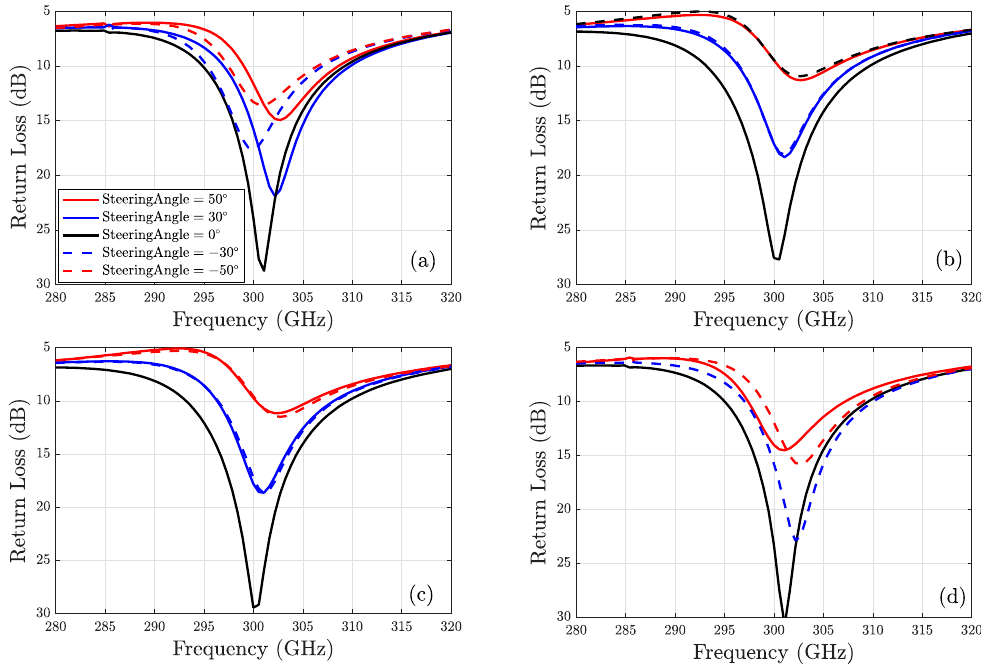
Figure 5. ( a ) Active return loss of Element #1 for varying steering angles, ( b ) active return loss of Element #2 for varying steering angles, ( c ) active return loss of Element #3 for varying steering angles, ( d ) active return loss of Element #4 for varying steering angles of radiating elements.